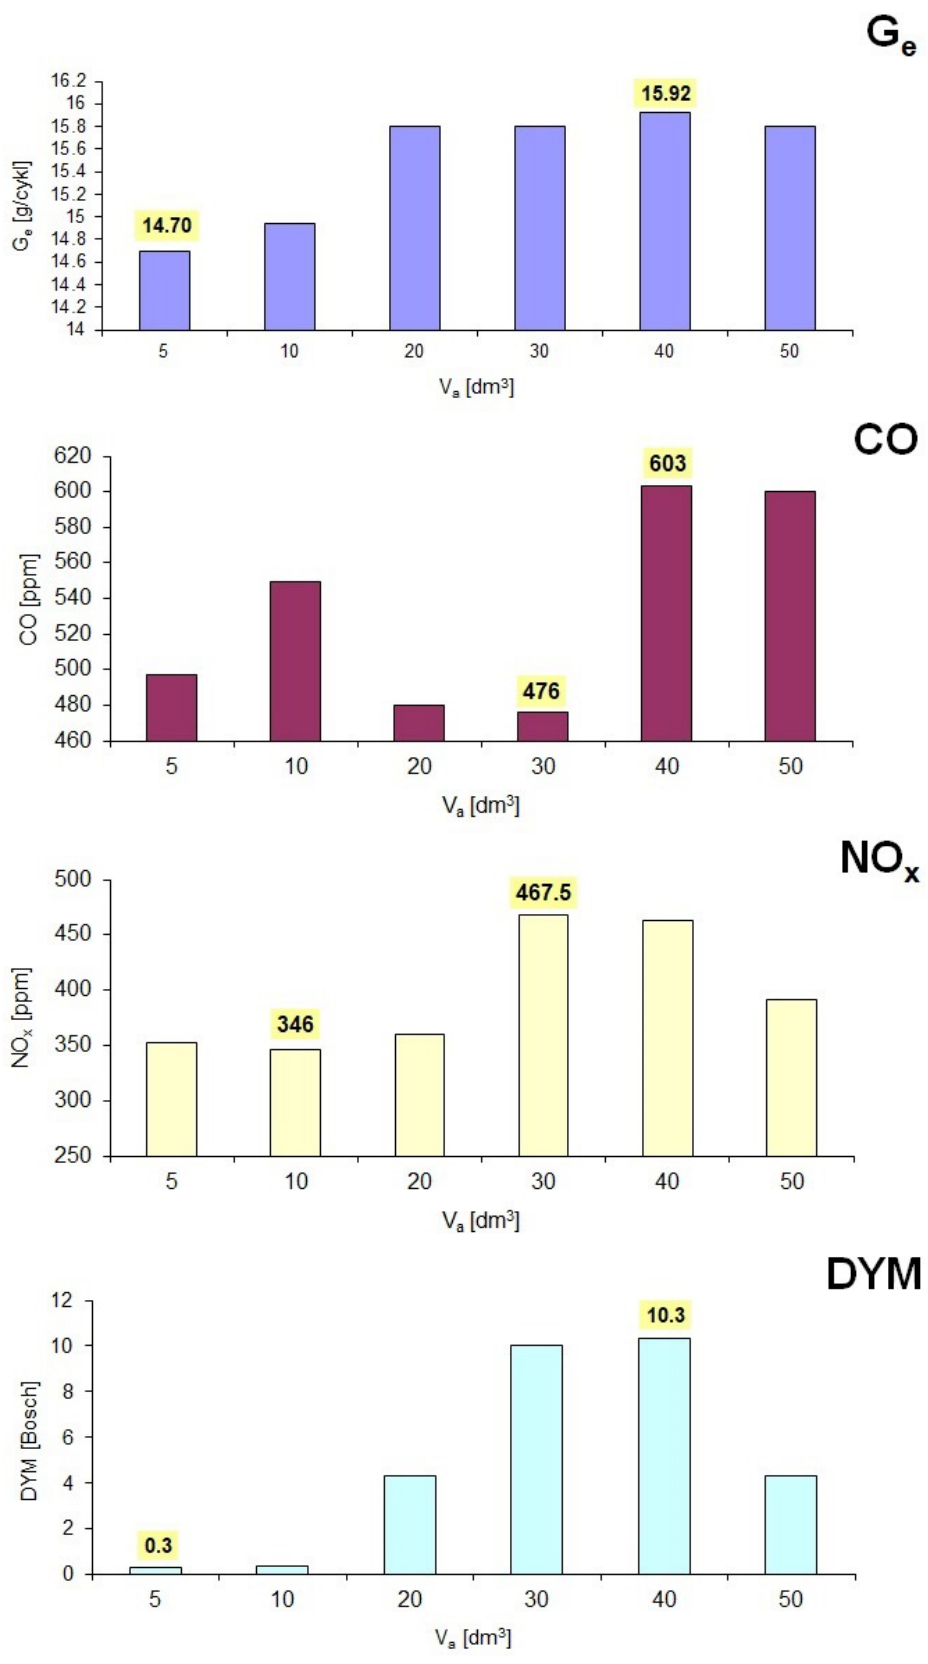
Figure 14. Influence of hydraulic accumulator capacity on values of optimization criteria for load